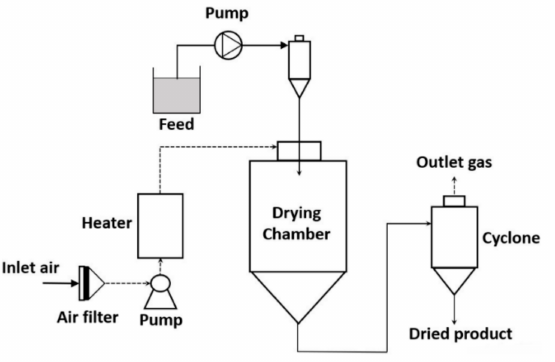
Figure 3. Schematic diagram of the spray-drying process (self-developed, the concept was adopted from